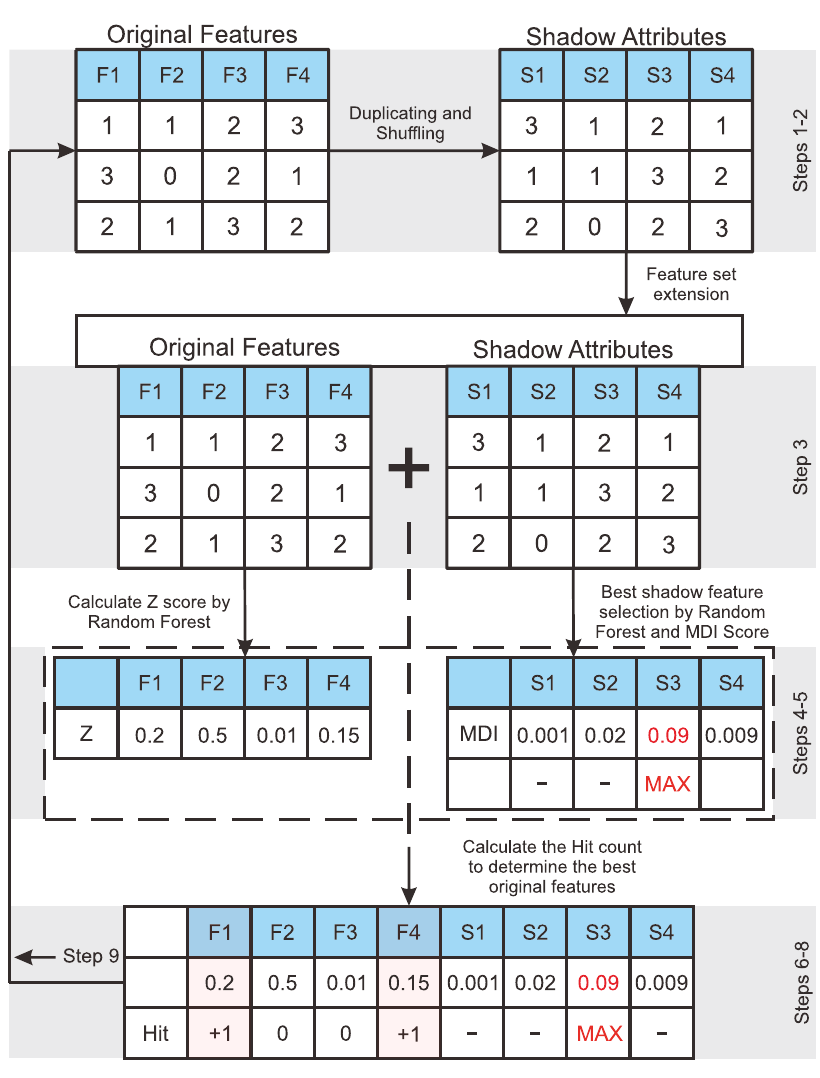
Figure 8. The Boruta feature selection scheme.